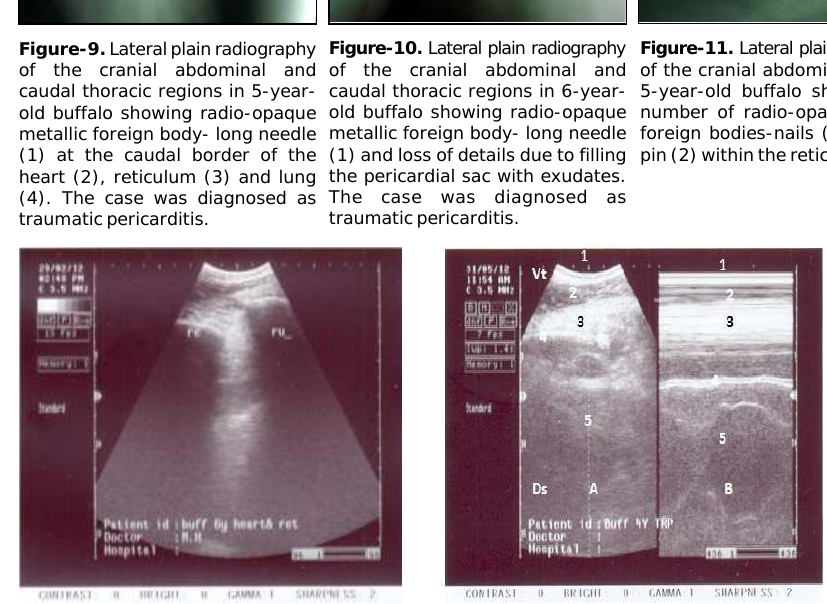
Figure-15. Lateral view of ultrasonography in 4-year-old buffalo: Application of rd th transducer on 3 and 4 ICS showing have moon shape of reticulum inside the thorax. The case was diagnosed and confirmed as diaphragmatic